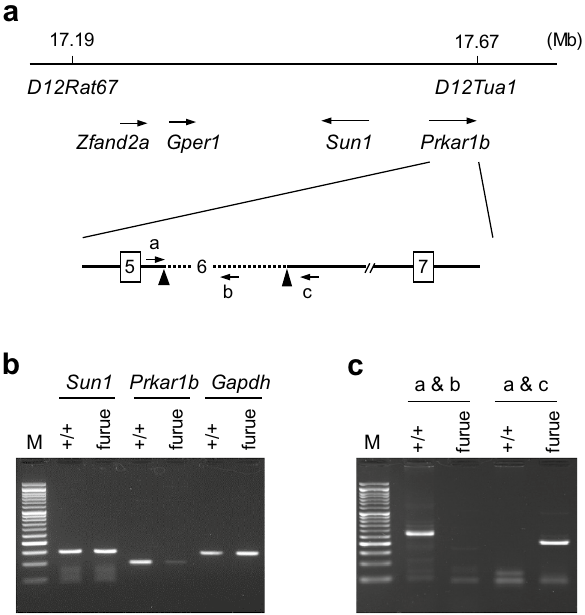
Figure 1. Positional cloning of furue . ( a ) Physical map of the furue locus. The furue locus was defined by D12Rat67 and D12Tua1 . Their physical positions are shown above the map (Rnor_6.0 assembly). The positions and directions of four characterized genes are indicated by horizontal arrows below the map. The deletion containing exon 6 (62 bp in length) of the Prkar1b gene of the furue genome is represented by a dashed line. Breakpoints of the deletion are indicated by arrowheads. Primers to detect the wild-type (a and b) and deletion (a and c) alleles are indicated by arrows. ( b ) Semi-quantitative RT-PCR analysis of Sun1 and Prkar1b mRNA. M, 50-bp DNA ladder molecular marker. ( c ) Genomic DNA PCR for genotyping the furue deletion. Primers a, b, and c represent rPrkar1b-wild-F, rPrkar1b-wild-R, and rPrkar1b-del-R, respectively. The positions of primers are depicted in Supplementary Fig.